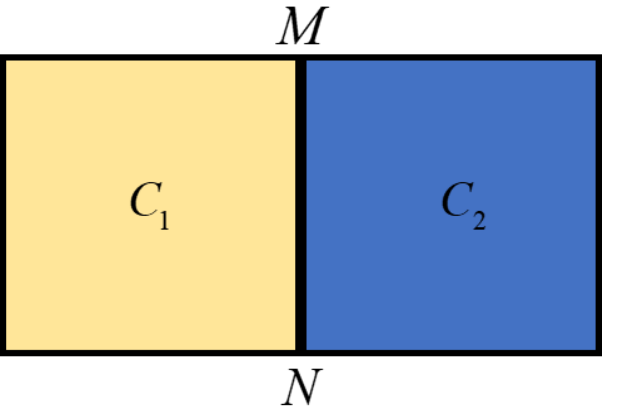
Figure 2. The ambiguity of inner boundary. MN is the edge shared by adjacent material spaces. According to Ellul [30] “in 3D, for the manifold to be valid, the neighborhood of each point within the sub-space must be able to be deformed into a sphere. Thus, self-intersecting surfaces are non-manifold”. It usually consists of a finite number of manifolds sharing boundaries as shown in Figure 3.